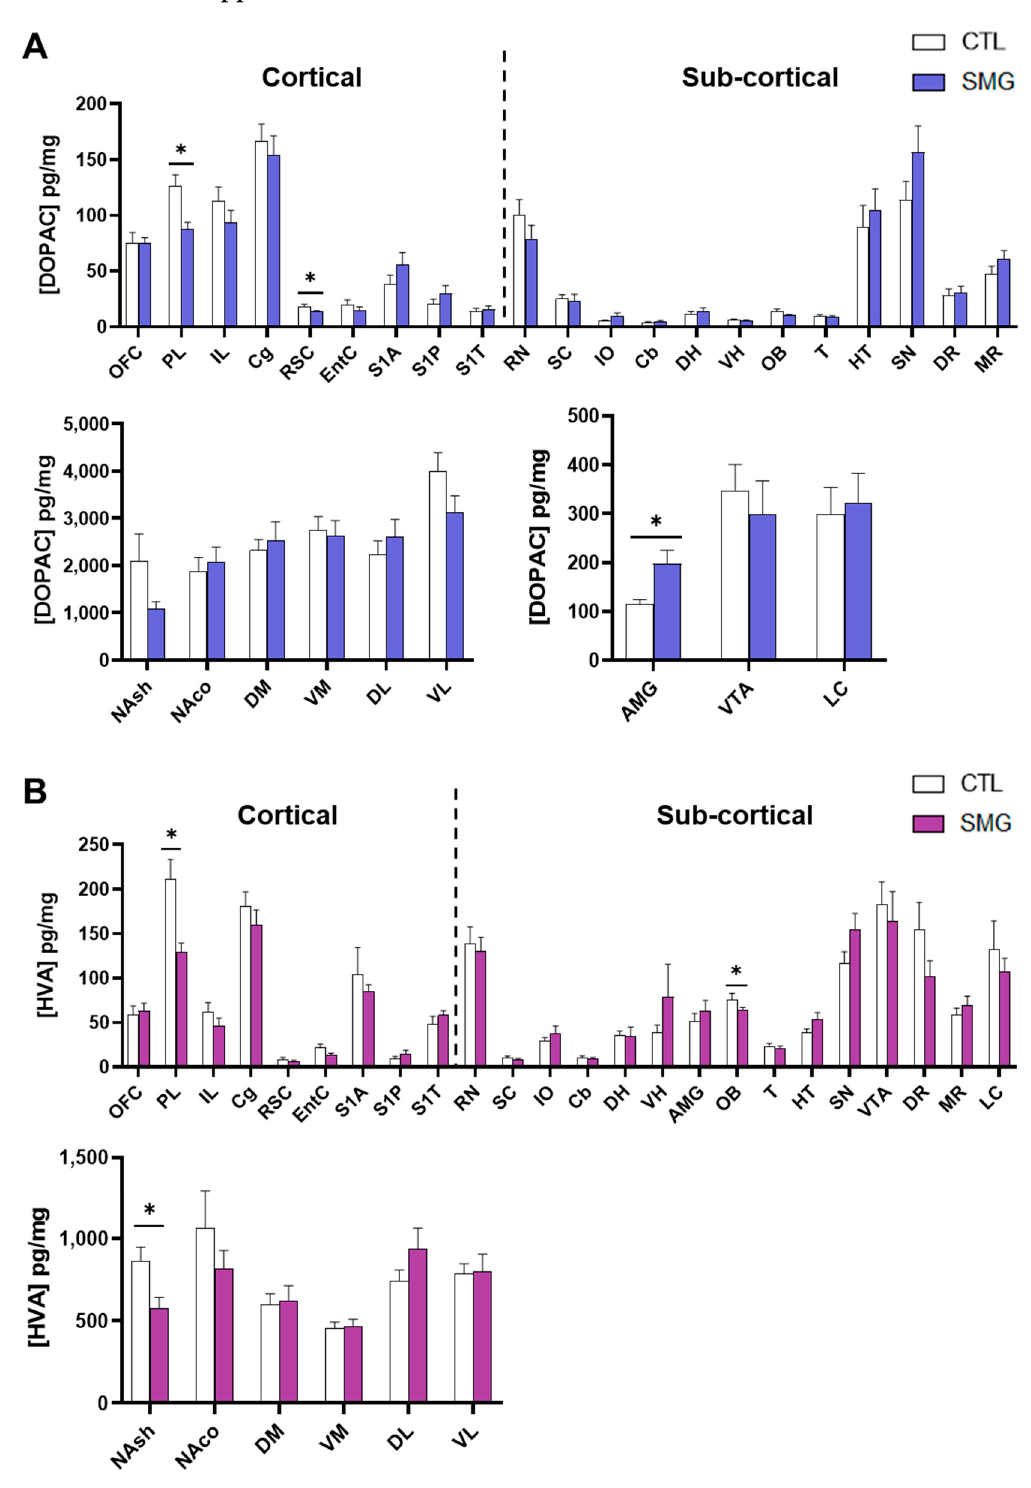
Figure A1. Effect of SMG on DOPAC ( A ) and HVA ( B ) tissue content in the brain. All data are presented as mean ± sem ( n = 12 rats/group). * p < 0.05, significant difference between the SMG and CTL groups (Mann–Whitney